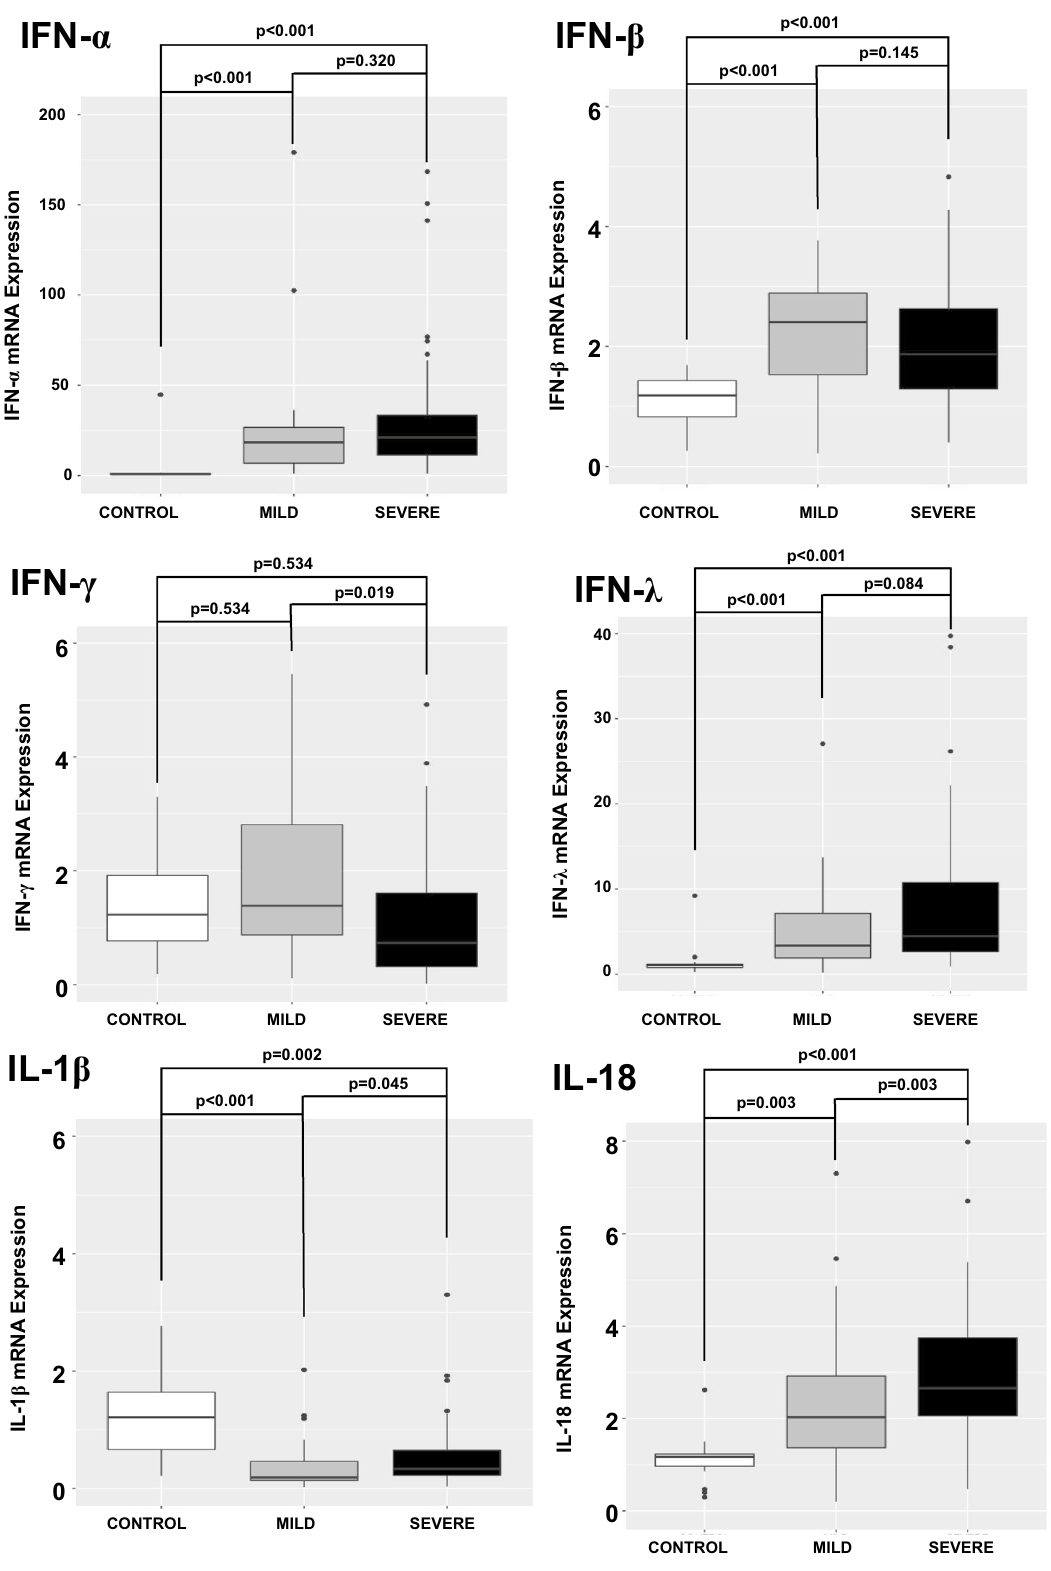
Figure 2. Quantitative mRNA of cytokines in circulating leukocytes of patients with COVID-19 on admission day. Expression of mRNAs of cytokines was measured in circulating leukocytes. IFN-α, IFN-β, IFN-λ, and IL-18 were increased in COVID-19 patients (N = 79 patients; 29 MILD and 50 SEVERE) when compared to CONTROL subjects (N = 17 patients). Pro-IL-1β mRNA was decreased in COVID-19 patients when compared to CONTROL subjects. No difference in IFN-γ expression was observed between CONTROL and COVID-19 patients. P values were calculated using the nonparametric Kruskal–Wallis test in R software (version 4.0.3 for